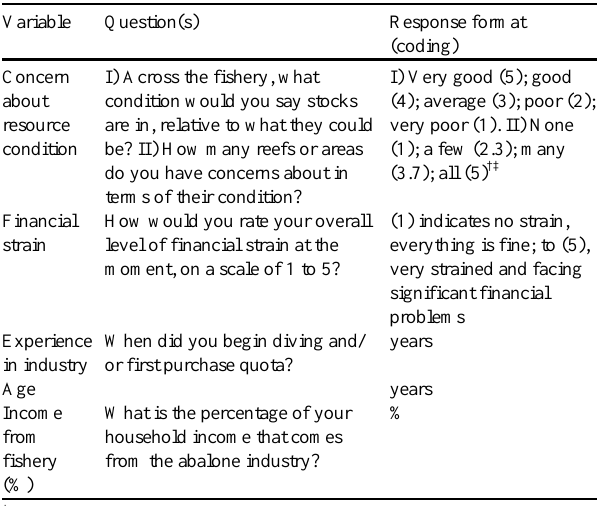
Table 2 . Survey questions used to measure predictor variables.